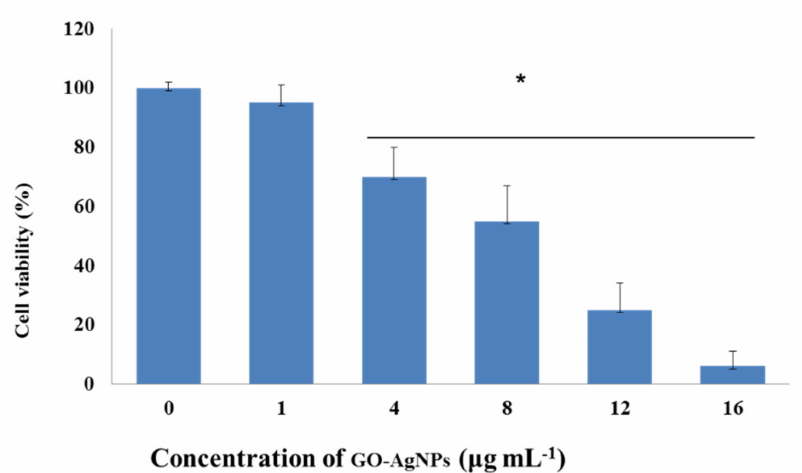
Figure 2. Effects of GO-AgNPs on the proliferation of caprine fetal fibroblast cells (CFFCs). CFFCs were exposed to 0, 1, 4, 8, 12, and 16 µ g/mL of GO-AgNPs for 24 h. The percentage of cell viability was then calculated relative to the control group (0 µ g/mL). Values are presented as the mean ± SD of four independent experiments (* p < 0.05).